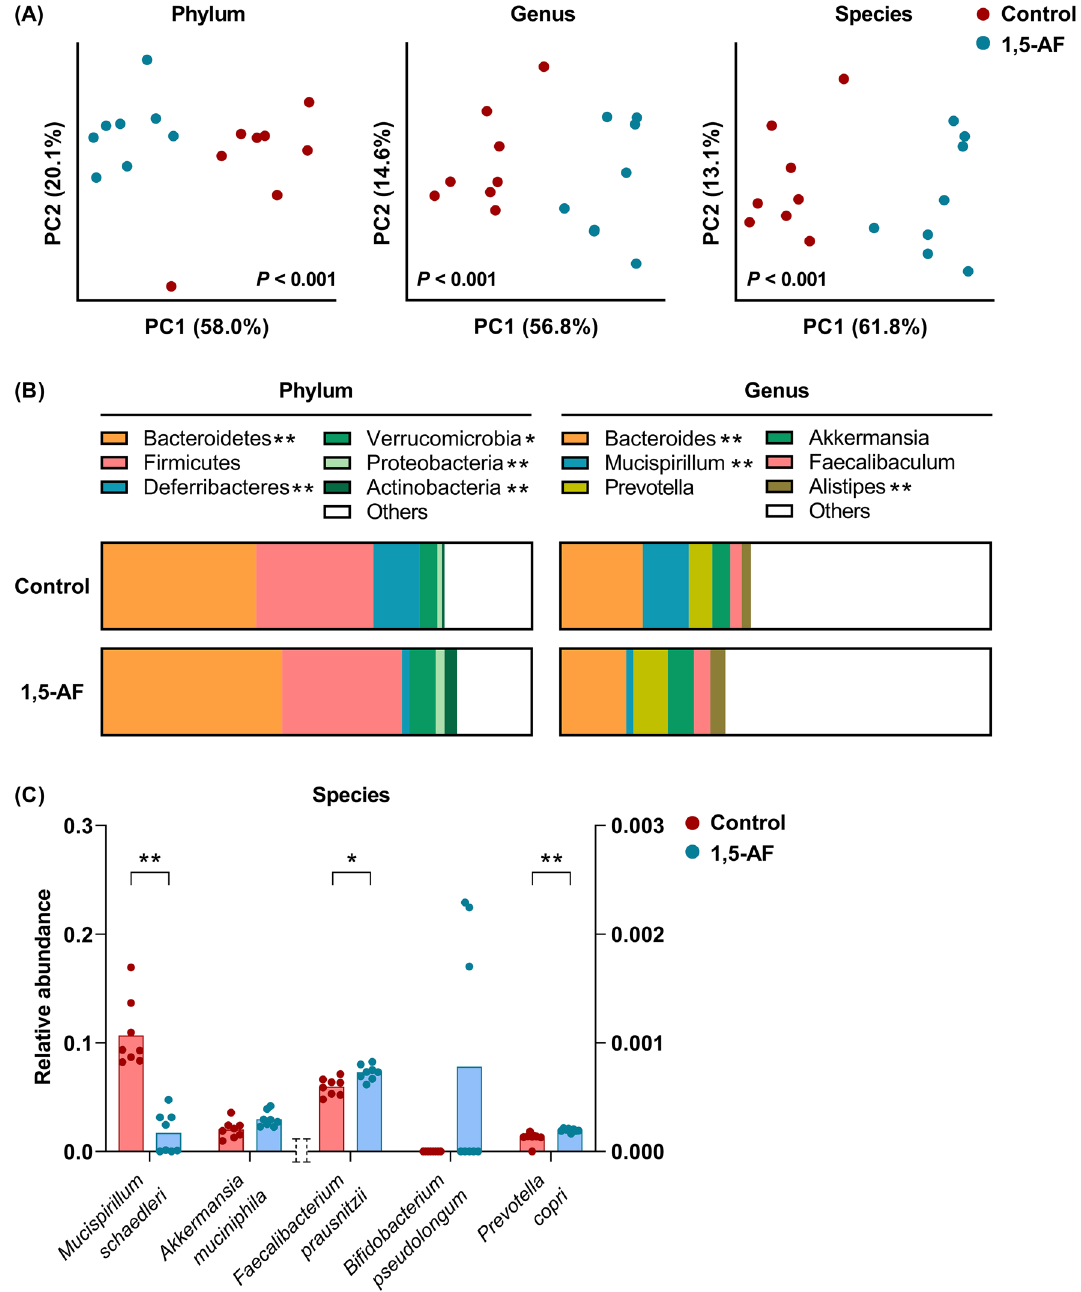
Figure 1. Dietary supplementation with 1,5-AF modulated gut microbiota in mice. ( A ) Principal coordinate analysis (PCoA) indicated that mice supplemented with or without 1,5-AF (n = 8, each group) were distinguishable by the structure of the gut microbiota at the phylum, genus, and species levels. Statistical significance of the differences between groups was calculated by PERMANOVA. ( B ) At the phylum level, relative abundance of Bacteroidetes was high in mice supplemented with 1,5-AF. Within Bacteroidetes, the genus Bacteroides was less abundant, whereas genera Prevotella and Alistipes were more abundant in mice supplemented with 1,5-AF. Mean values of the mice in each group (n = 8) are shown. ( C ) Relative abundances of each microbial species in mice supplemented with 1,5-AF (n = 8) were compared with those in control mice (n = 8). M. schaedleri and A. muciniphila are assigned to the left axis and F. prausnitzii , B. pseudolongum , and P. copri are assigned to the right axis. Bars indicate mean values. *P < 0.05 and **P < 0.01, determined by Mann– Whitney test with FDR adjustment for multiple